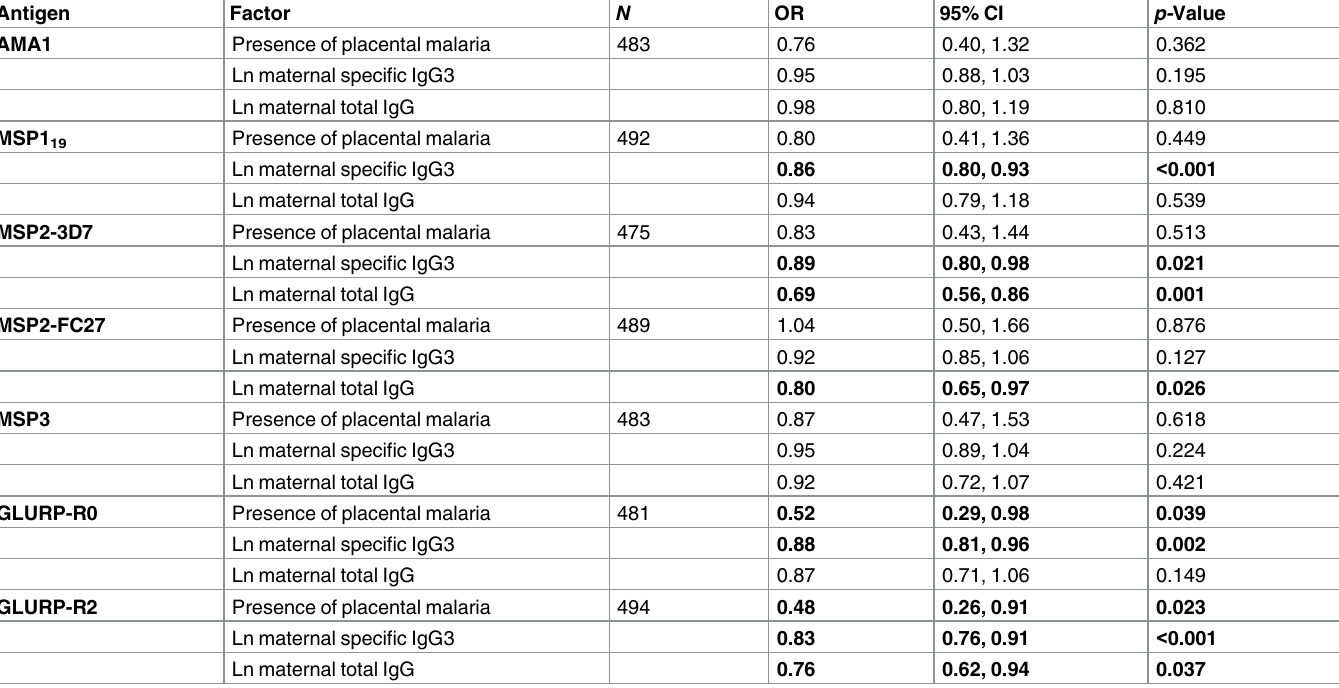
Table 2. Association between cord-to-mother ratio (CMTR) and factors that could influence transplacental transfer:Placental malaria, maternal total IgG, and maternal malaria-specific IgG3. Antigen Factor N OR 95% CI p- Value